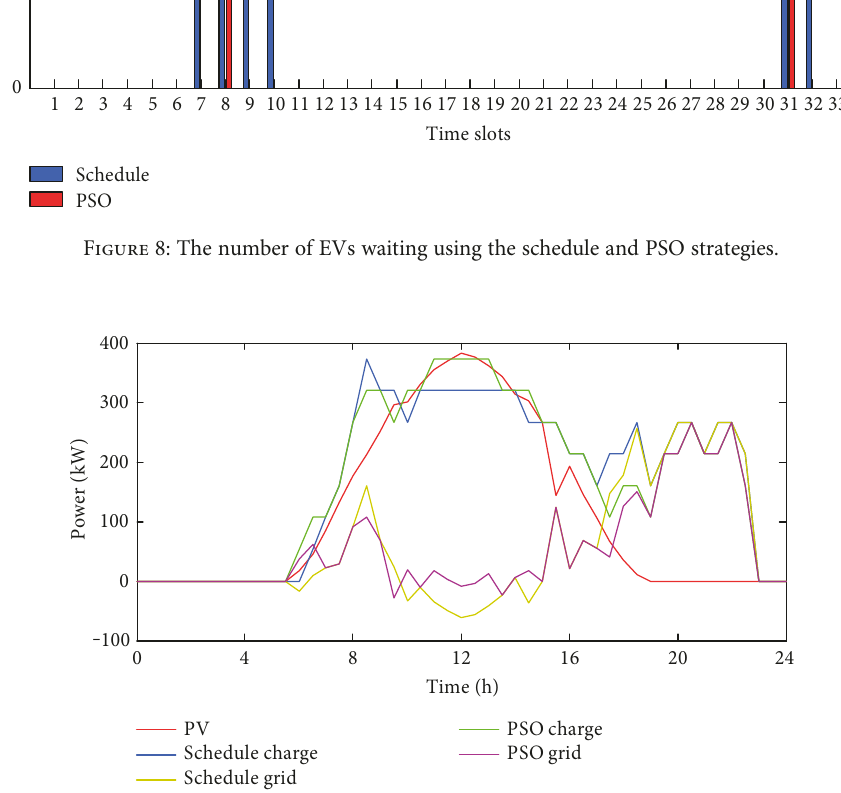
Figure 9: Power distribution results using the schedule and PSO